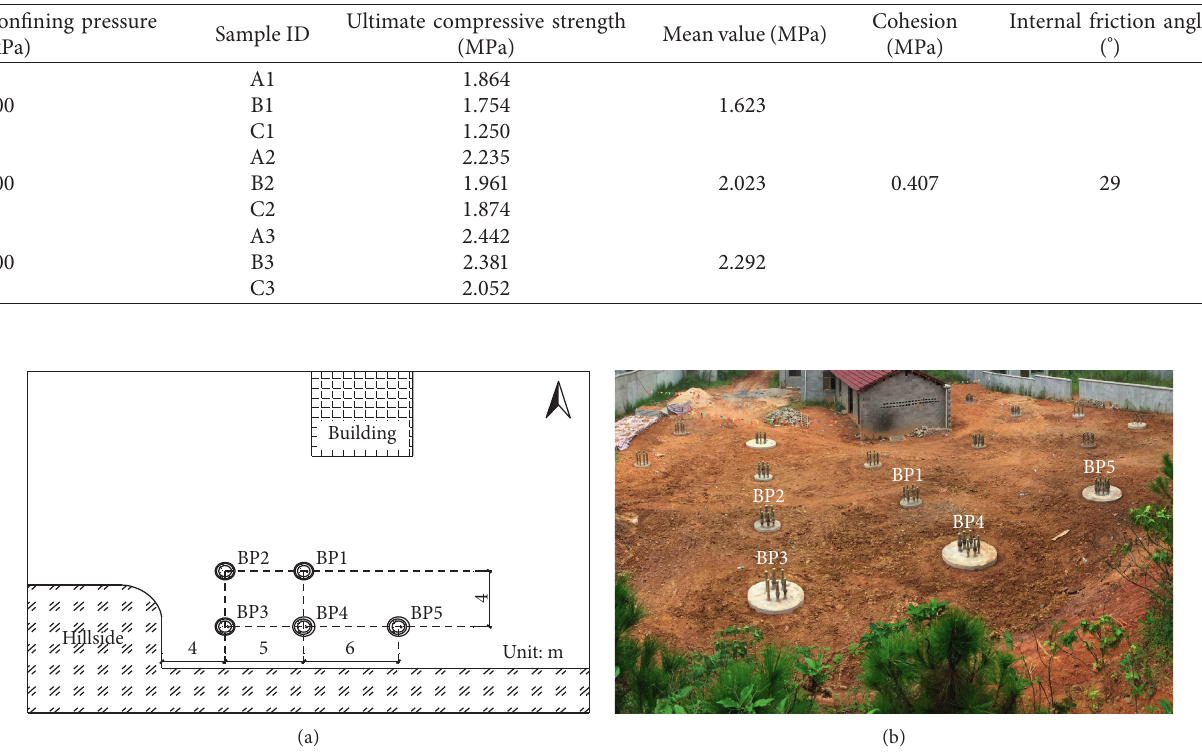
Figure 2: (a) Layout chart and (b) photo indicating the arrangement of belled piers within the implementation